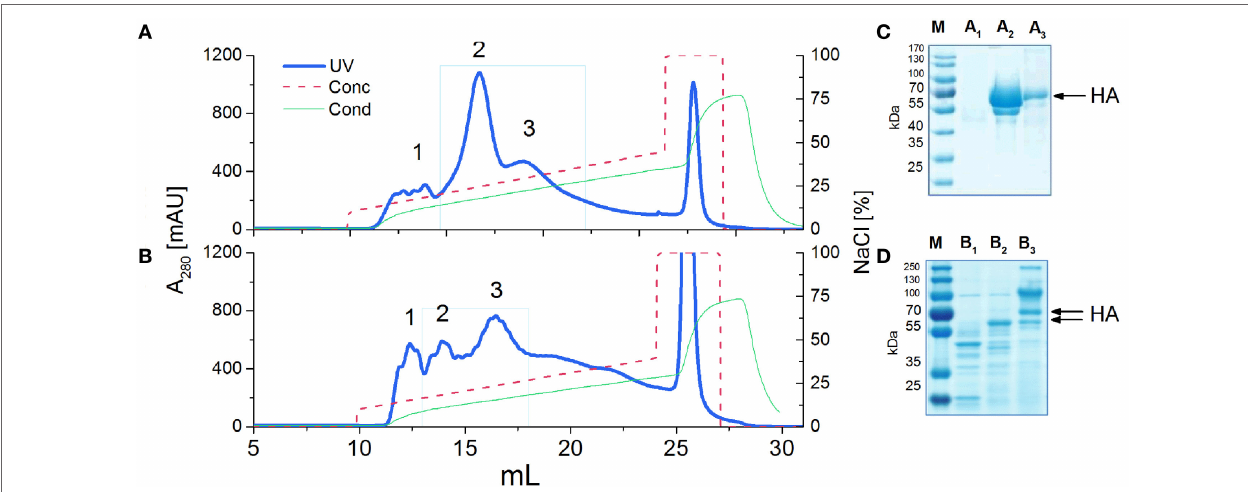
FigUre 1 | ion exchange chromatography (iec) (a,B) and sDs-Page analysis (c,D) of h5 antigens . IEC chromatograms (a,B) present typical purification profiles of H5 hm and H5 Man5 proteins, respectively. Absorbance at 280 nm is shown. HiTrapQ column was pre-equilibrated with 10 mM Tris/HCl pH 7.6 (Buffer A). Proteins were eluted with 10 mM Tris/HCl pH 7.6; 1 M NaCl (Buffer B) applying a linear gradient from 10% B to 45% B at flow rate 0.25 ml/min. Collected fractions (1, 2, 3) were analyzed on 4 − 12% SDS-PAGE (c,D) following Coomassie staining. HA protein was detected in peak no 2 and 3 [ (c) : line A 2 and A 3 ; (D) : line B 2